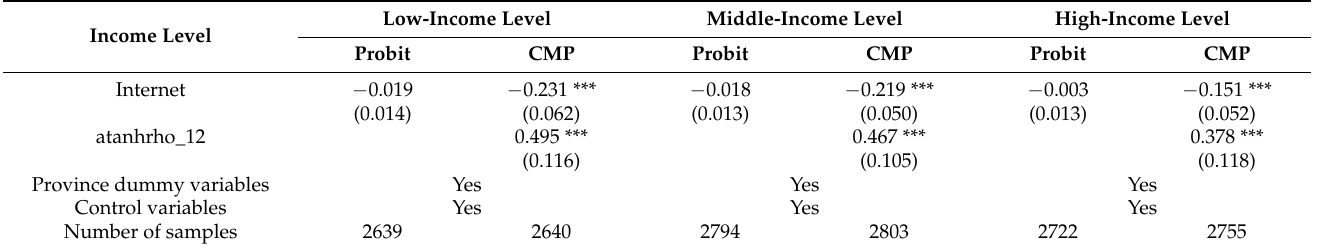
Table 4. Income-level regression